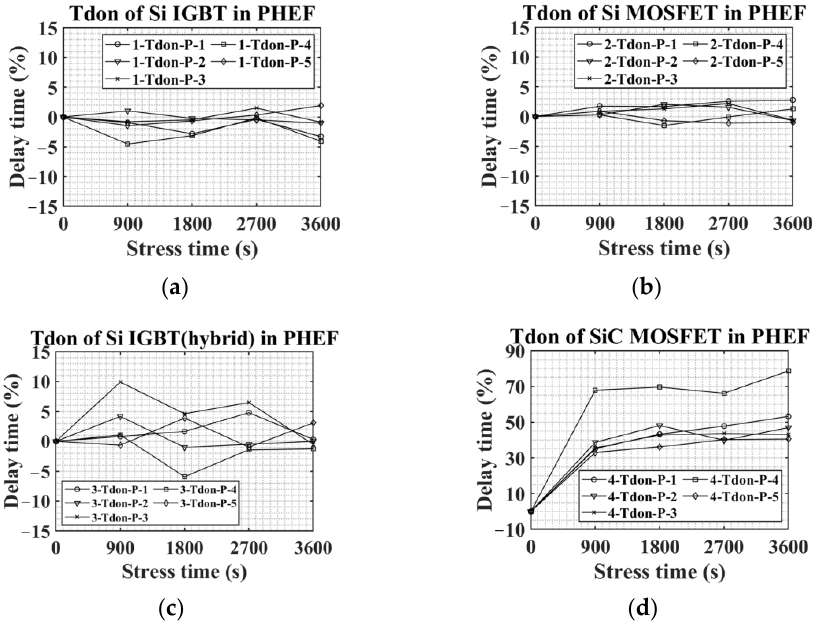
Figure 13. T don variations in PHEF stress: ( a ) Si IGBT, ( b ) Si MOSFET, ( c ) Si IGBT with SiC diode, and ( d ) SiC MOSFET. ( d ) SiC